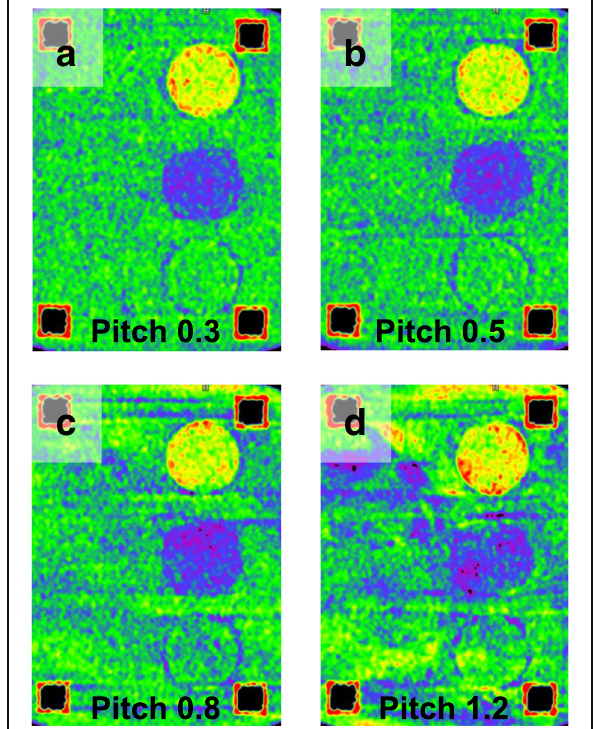
Fig. 4 Lower pitch image acquisition reduced spiral-like artefacts in virtual non-calcium images. Orthogonal reformats ( a – d ) of virtual non-calcium images acquired at different pitch angles. Notice that spiral-like artefacts clearly visible at pitch 1.2 and 0.8 have almost disappeared at pitch